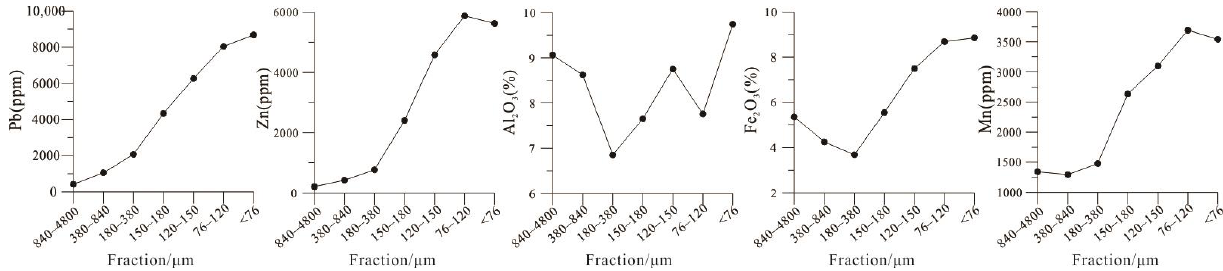
Figure 14. Pb, Zn, Al 2 O 3 , Fe 2 O 3 , and Mn line chart in different size fractions of soil in the arid Gobi Desert covered areas. In the arid Gobi Desert area, aeolian sand is the main factor that interferes with the sampling medium for geochemical exploration. Aeolian sand accounts for a very low proportion in the >830 and <120 µ m particle sizes, and more than 90% of aeolian sand is concentrated in 120–830 µ m. Therefore, coarse-grained soil (>830 µ m) and fine-grained soil (<120 µ m) are not disturbed by aeolian sand, and both may be effective sampling media for geology and mineralization studies [53]. The coarser fraction of soils (weight percentage is 21.9%) consists largely of quartz and feldspar, followed by gypsum and calcite. The intermediate fraction (120–830 µ m) is dominated by quartz, gypsum, feldspar, and calcite, with small amounts of clay minerals, and its weight percentage is 58.6%. The fine fraction (weight percentage is 19.5%) consists largely of calcite and clay minerals, including illite, kaolinite, and chlorite [42]. As the particle size of the sample changes from large to small, a few trends were observed: (1) the content of quartz and feldspar gradually decreases—the coarser fraction of soils contains 32.4% quartz and 33% feldspar, while the fine fraction contains 13.6% quartz and 9.4% feldspar, respectively, and (2) the content of clay minerals gradually increases, and the content of clay minerals in the coarser fraction of soils is 7.7%, and 40.3% in the fine fraction. In addition, the alkaline soil (with a pH value of 7.5–9.5) might arise because evaporation exceeds rainfall in this region and the rock-based material in the overburdened soil accumulates on the surface under the effect of evaporation, making the surface soil alkaline [54]. The Eh negatively correlates with the pH. When the pH changes within a certain range, the amount of zeta potential on the surface of clay minerals also changes. Under alkaline conditions, the amount of negative charge on the surface of clay minerals is increased [55]. This is also confirmed in the experiment of kaolinite and halloysite adsorption of rare earth elements [55]. Additionally, the electrical conductivity of fine-grained samples in surface soil was significantly higher than that of coarse-grained samples [54]. These may make positively charged metal ions more easily adsorbed by fine-grained